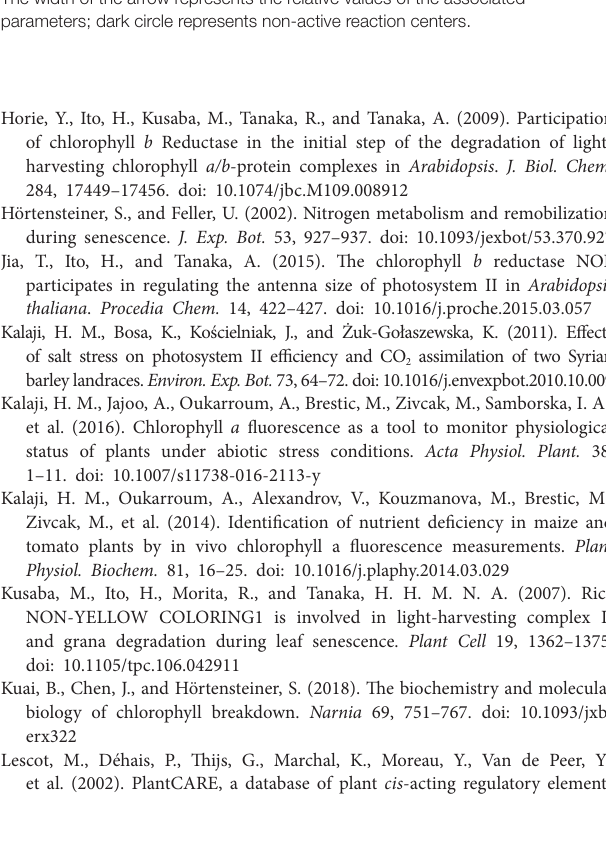
Supplementary Figure 1 | Yeast two-hybrid analysis of ZjNOL and ZjNYC1. Supplementary Figure 2 | The OJIP curves, K-band, and G-band. (A) The OJIP curves. (B) K-band. (C) G-band. Supplementary Figure 3 | The proportion of phenomenological energy flux parameters of the transgenic lines and the control displayed by the leaf pipeline model. The fluorescence parameters were displayed as means of ten replicates. The width of the arrow represents the relative values of the associated parameters; dark circle represents non-active reaction